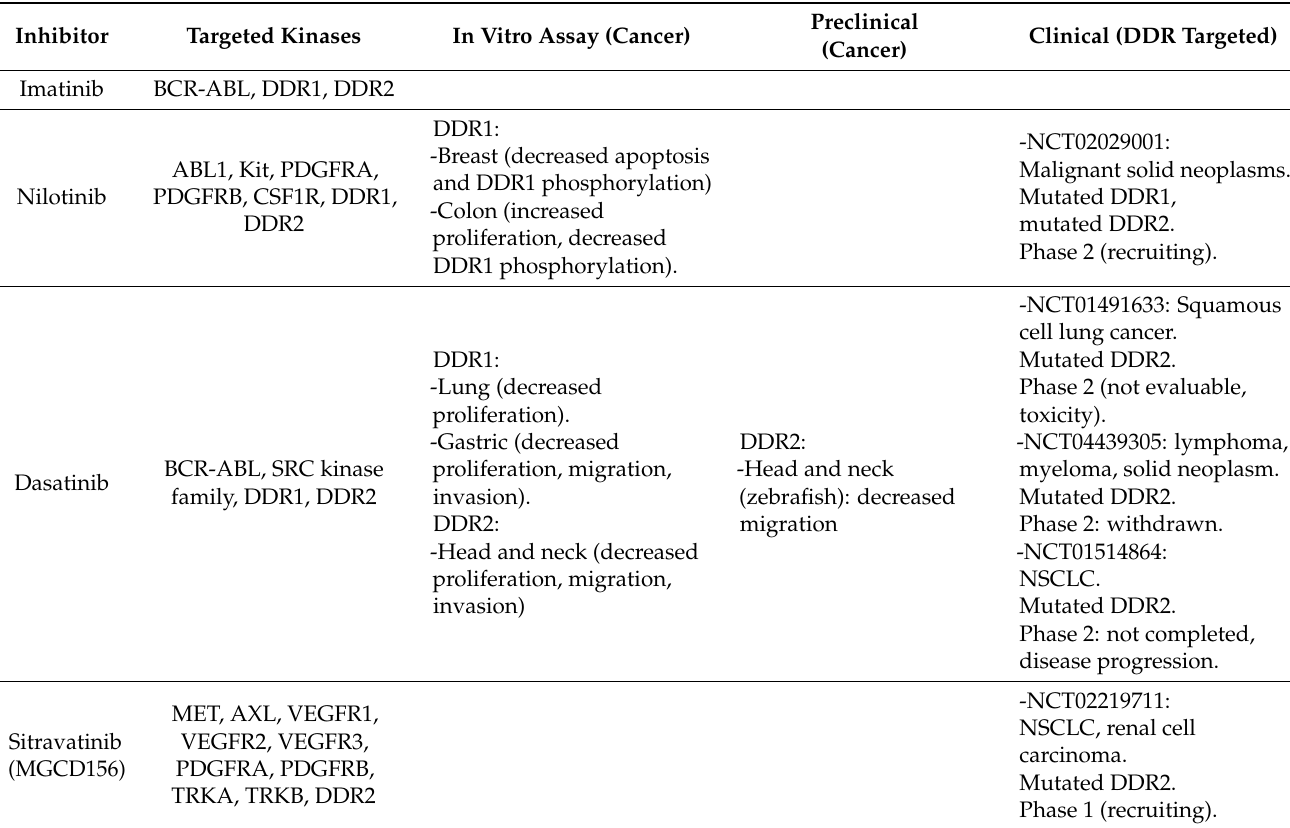
Table 5. Nonspecific DDR inhibitors: specificities and clinical trials (adapted from